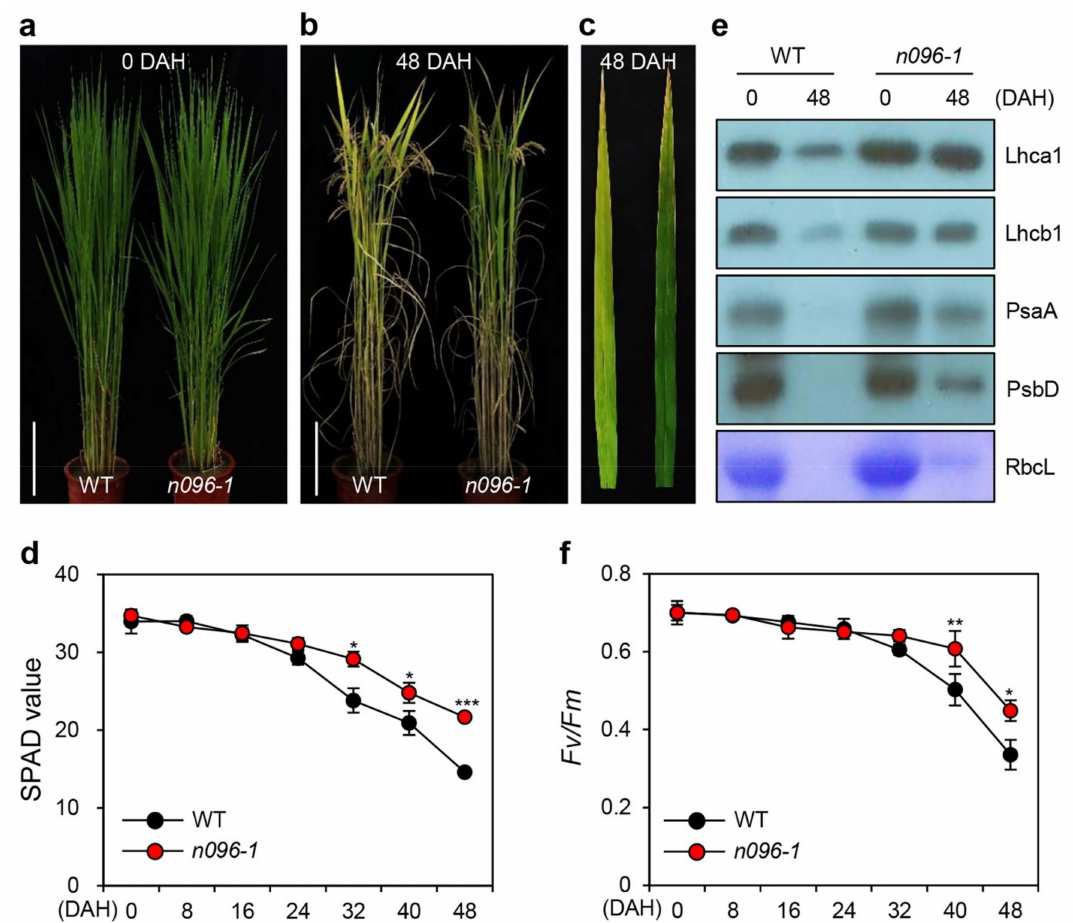
Figure 2. The onac096-1 mutant exhibits delayed natural leaf senescence. The rice plants were grown in the field under natural long-day conditions ( ≥ 14 h light / d). ( a – c ) Phenotypes of WT and onac096-1 ( n096-1 ) plants at 0 DAH ( a ) and 48 DAH ( b ). Bars = 20 cm. ( c ) Senescing flag leaves of WT (left) and onac096-1 (right) plants at 48 DAH. The photographs are representative of five independent plants. ( d – f ) Changes in photosynthetic proteins ( d ), SPAD values ( e ), and PSII activity ( Fv / Fm ) ( f ) in flag leaves of WT and onac096-1 plants after heading. SPAD values ( d ) and Fv / Fm ratios ( f ) were measured in the middle part of a leaf blade every 8 d from 0 to 48 DAH. ( e ) Immunoblotting performed using antibodies against photosynthetic proteins (Lhca1, Lhcb1, PsaA, and PsbD). Mean and standard deviations were obtained from 10 biological repeats ( d,f ). Asterisks indicate statistically significant di ff erences between onac096-1 and WT, as determined by Student’s t -test (* p < 0.05, ** p < 0.01, and *** p < 0.001). The experiment was repeated twice with similar